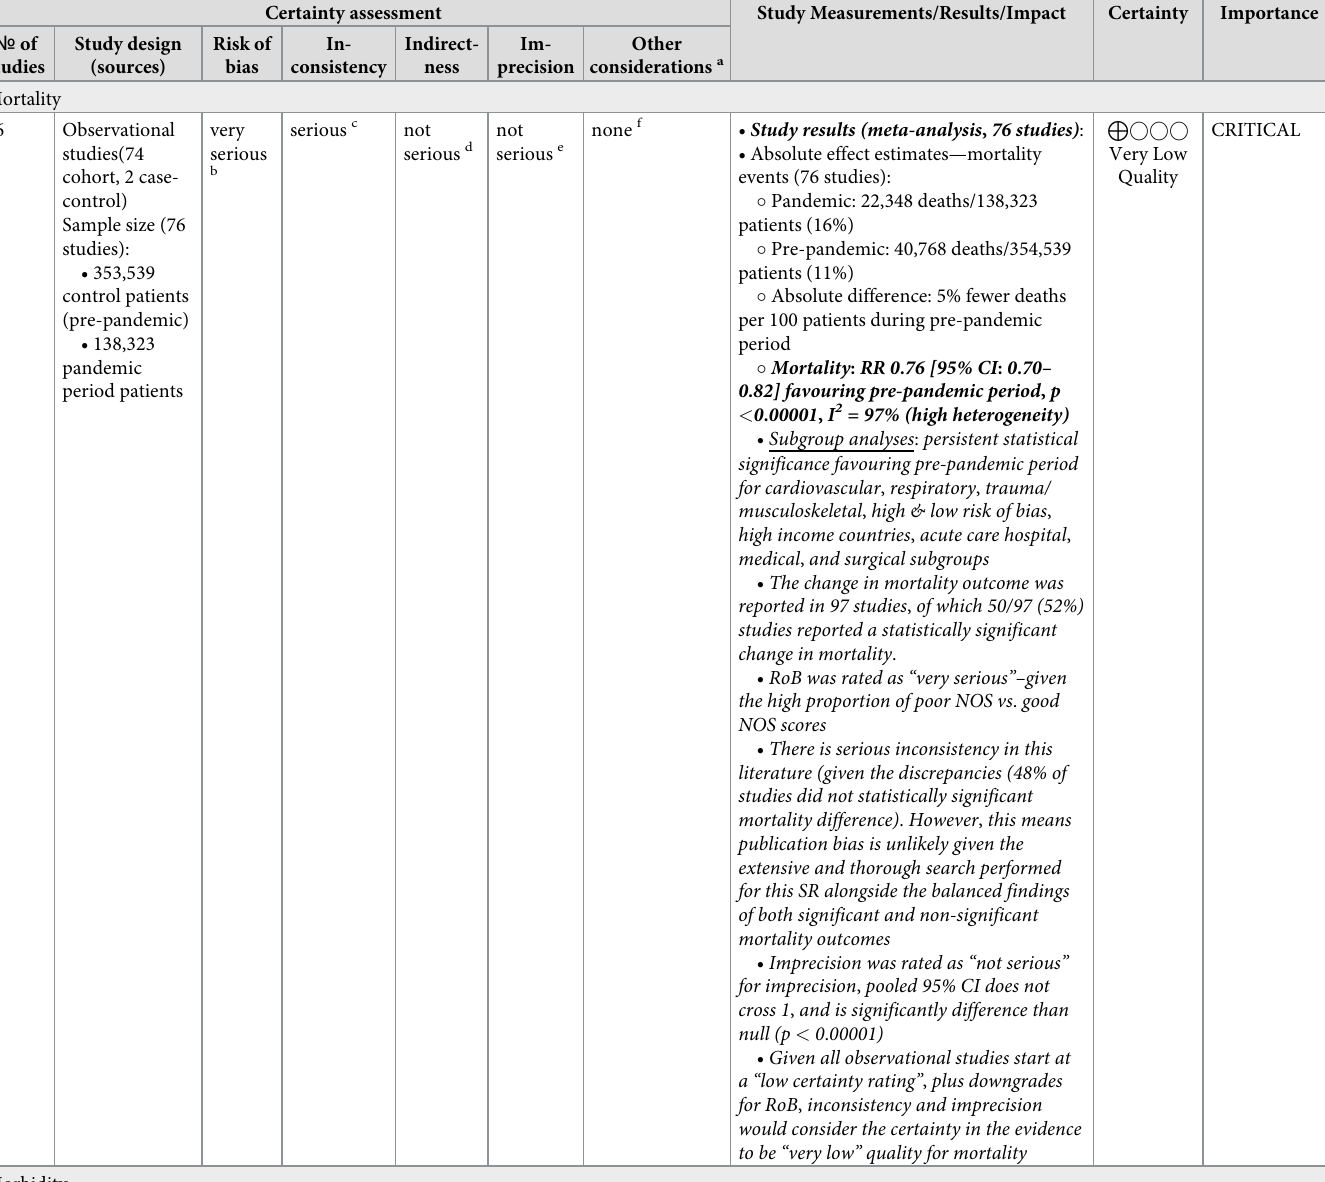
Table 2. Grading of Recommendations Assessment, Development and Evaluation (GRADE) of COPES outcomes: Mortality, morbidity, hospitalizations, disrup- tions to